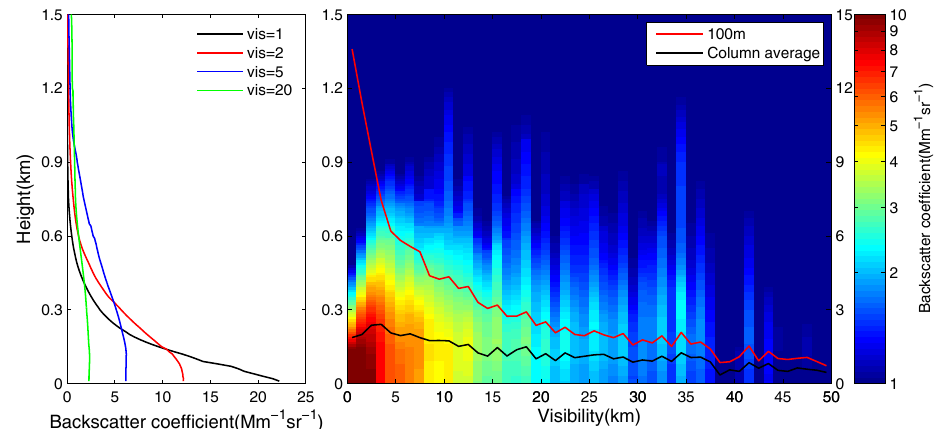
Figure 7. The vertical gradient of attenuated backscattering coefficients under different visibility conditions.